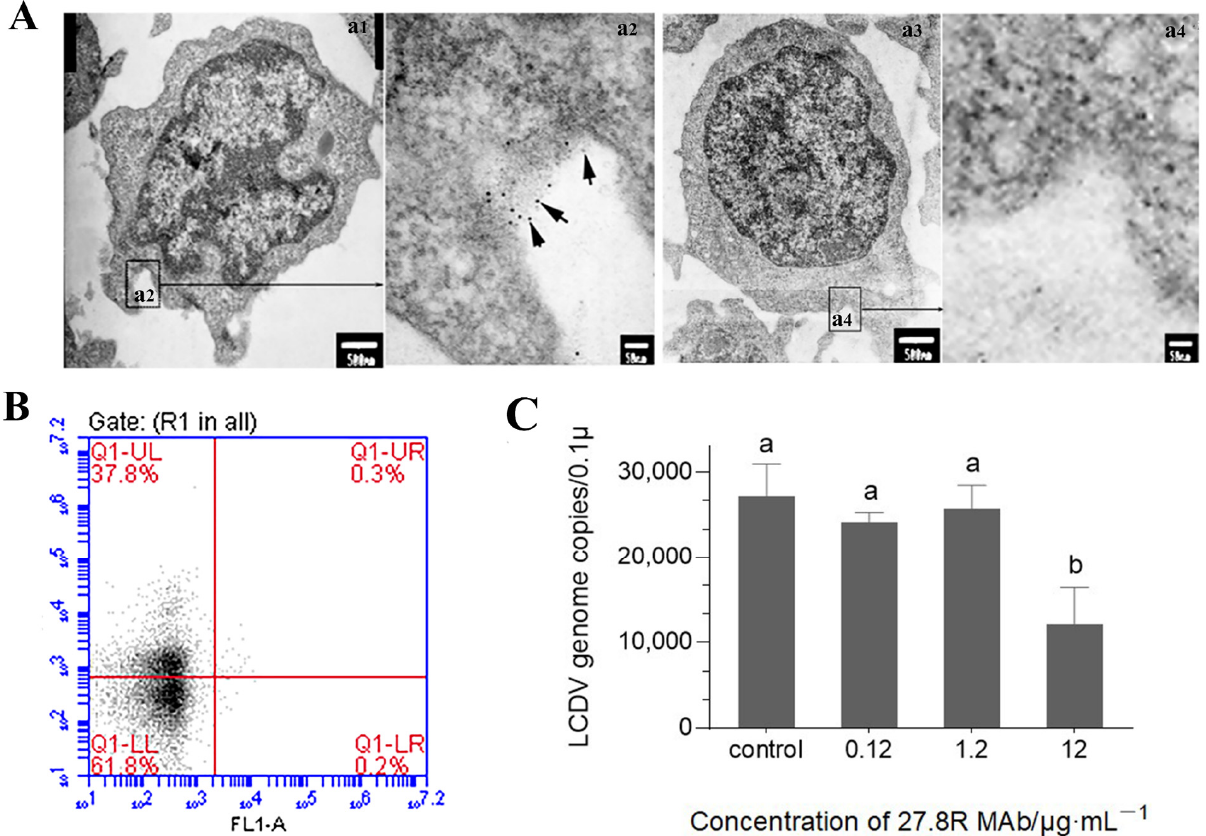
Figure 4. Location of the 27.8R on PBLs and antibody blocking assay using anti-27.8R MAb to inhibit LCDV infection of PBLs. ( A ) Immunogold electron micrograph of the 27.8R-expressing PBLs in healthy flounder. ( a1 , a3 ) The PBLs incubated with anti-27.8R and anti-WSSV MAb, respectively. Scale bar = 500 nm. ( a2 , a4 ) Higher magnification view of insert area from ( a1 ) and ( a3 ), respectively. The arrows showed gold particles representing the 27.8R. Scale bar = 50 nm. ( B ) Flow cytometry analysis showed the 27.8R + cells in PBLs by scatter diagram, Q1-UL represented 27.8R + cells. ( C ) The